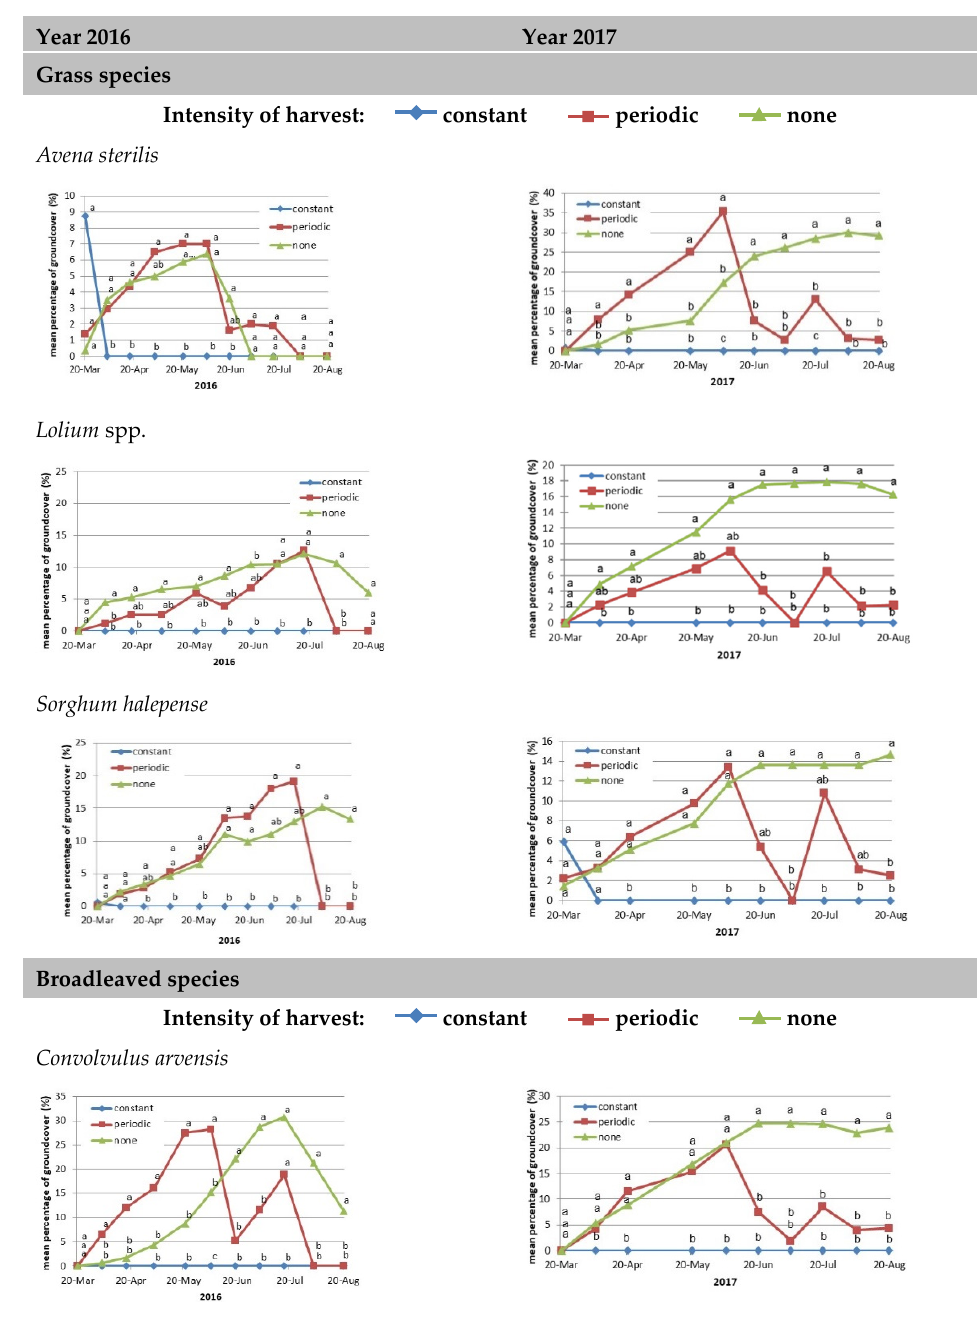
Figure 5. The mean percentage of groundcover for individual species naturally growing between the rows within the vineyard under different harvest treatments (constant, periodic, or none) during 20 March–20 August in 2016 and 2017. Means in columns not followed by the same letter are significant (Tukey HSD, at p < 0.05, n = 8).